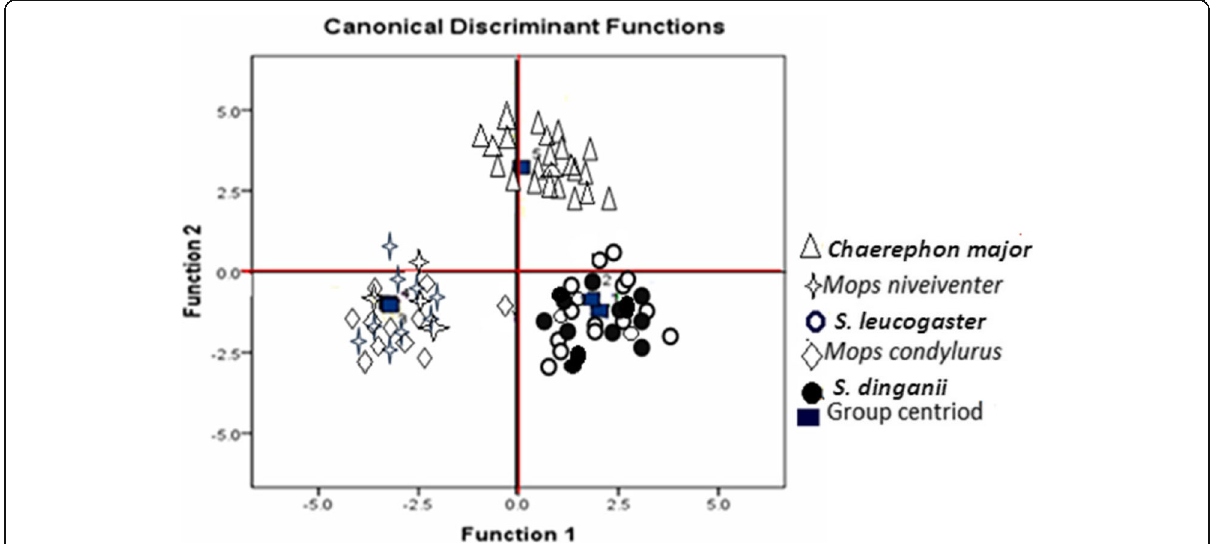
Fig. 2 The plot of mean canonical scores and the canonical discriminant functions of showing the separation of species by their calls in multidimensional